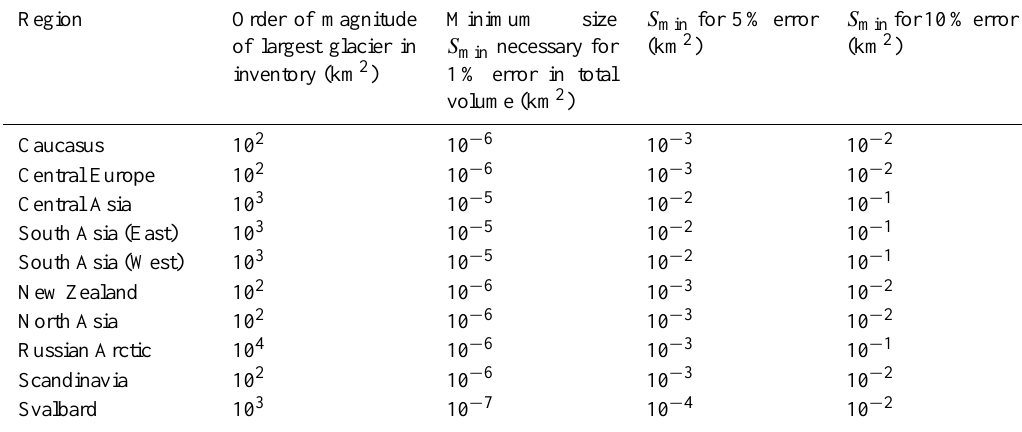
Table 1. A calculation of the smallest glaciers in an inventory that would be necessary for relative errors in total regional volume that are less than or equal to 1%, 5%, and 10%. Calculations are for 10 different glacierized regions around the world (Fig. 2) with inventories (Cogley, 2009) that are greater than 90% complete. For regions dominated by ice caps (Svalbard and Russian Arctic), calculations use the theoretically derived values of γ = 1 . 25 and β = 2 . 05. For regions dominated by glaciers, calculations use γ = 1 . 36 and β = 2 . 1. The maximum size glacier is estimated by order of magnitude. Results are also presented as order of magnitude estimates in km 2 . S min for 5% error Minimum size Region Order of magnitude S min necessary for (km 2 ) (km 2 of largest glacier in 1% error in total inventory (km 2 ) volume (km 2 )